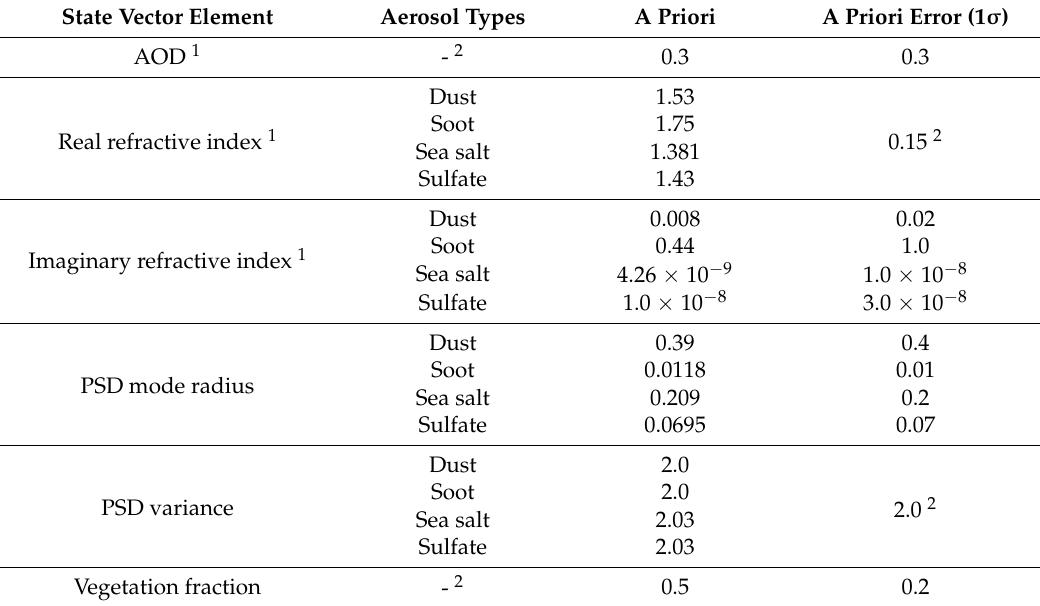
Table 2. State vector elements used in the simulation for each aerosol